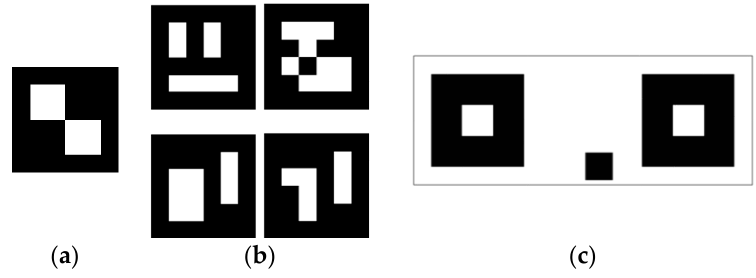
Figure 4. Targets provided by EM: ( a ) symmetric target; ( b ) asymmetric targets; and ( c ) stereo target.